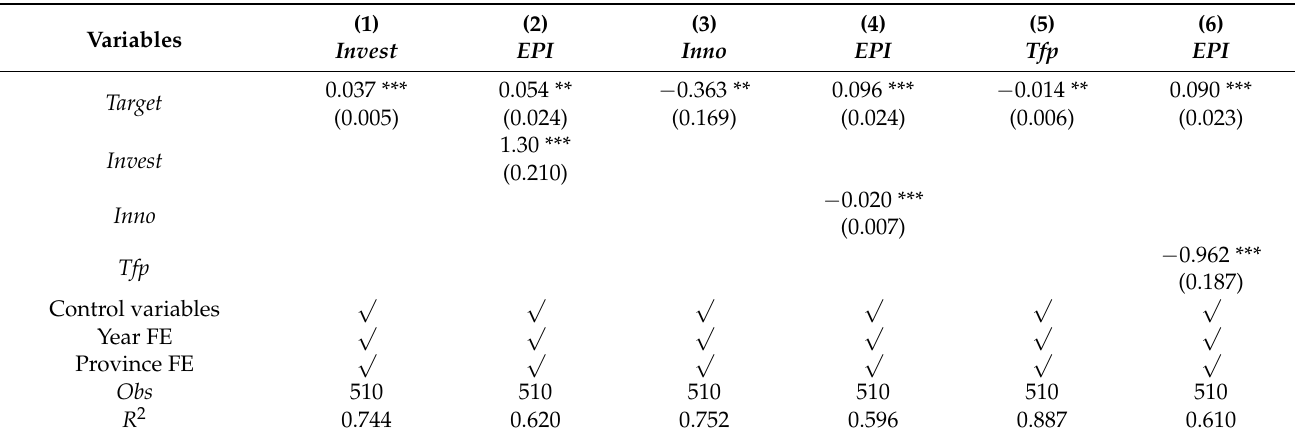
Table 5. Mediating effect